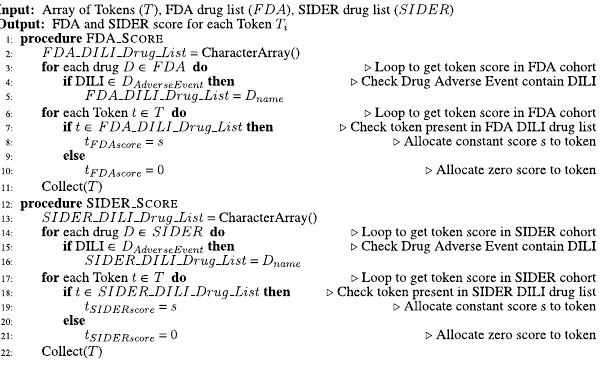
Algorithm 3. Add score for presence/absence in external cohort FDA and